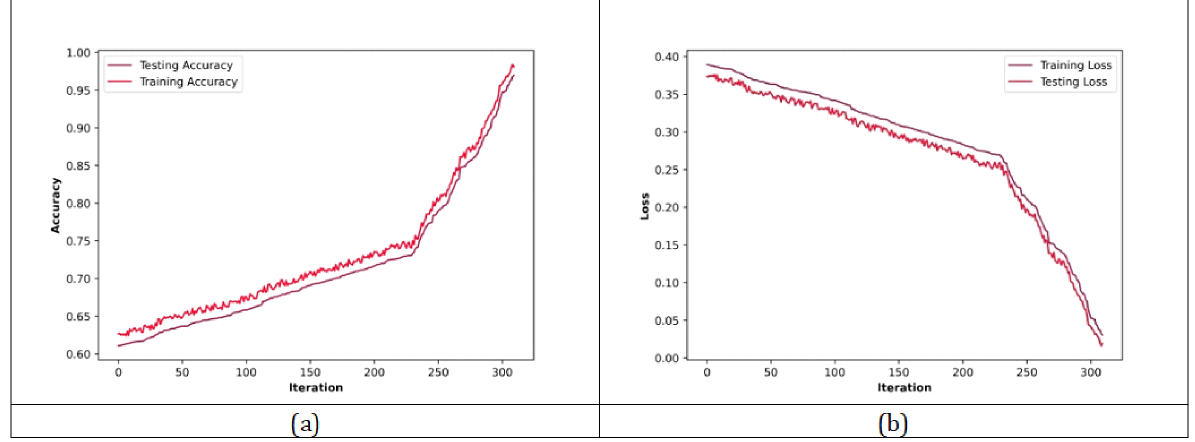
Figure 9. Performance analysis based on ( a ) accuracy and ( b ) loss for Review Rating Prediction using Yelp 2013 dataset.